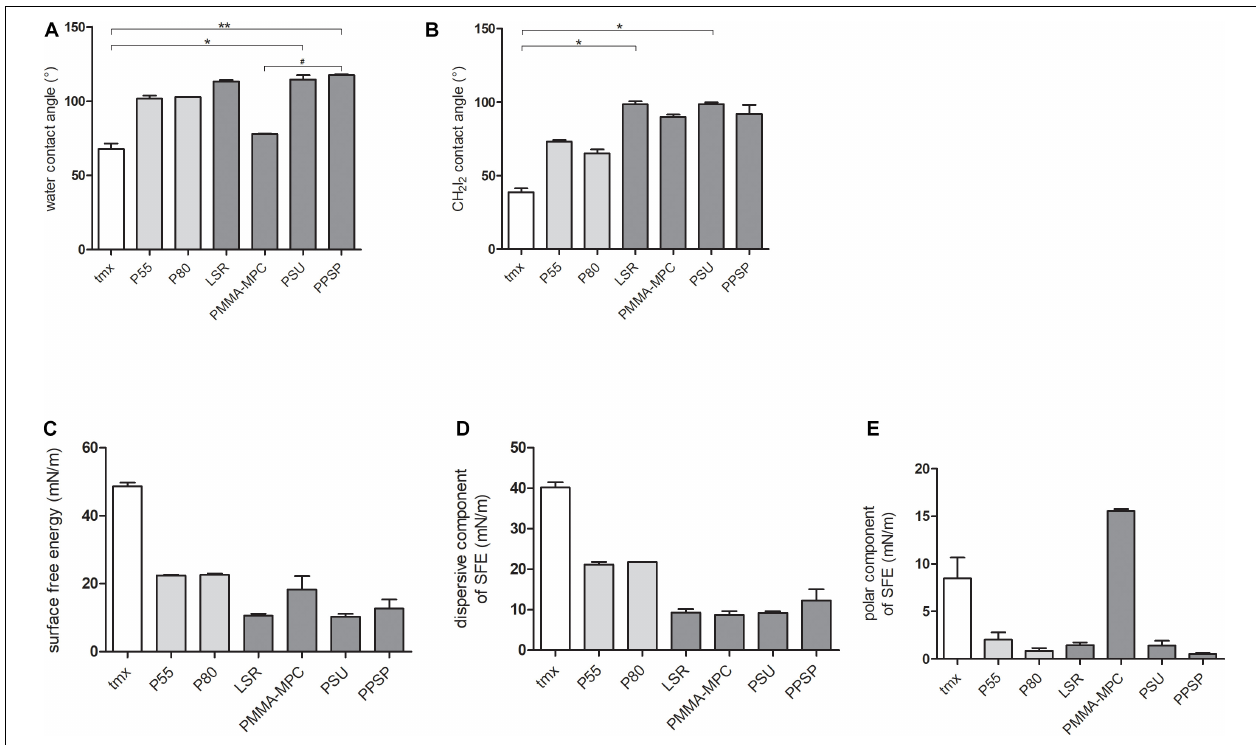
FIGURE 2 | Surface attraction properties of liquid silicon rubbers (LSRs) is decreased compared to thermoplastic polyurethane materials. (A) water contact angles (B) CH 2 I 2 contact angles (C) calculated SFE values (D) dispersive component of SFE and (E) polar component of SFE. Material surface characterization were carried out with n = 4. Data are represented as mean + SE Mean . Significances: * vs. tmx: * p < 0.05, ** p < 0.01, # vs. PMMA-MPC: # p < 0.05.